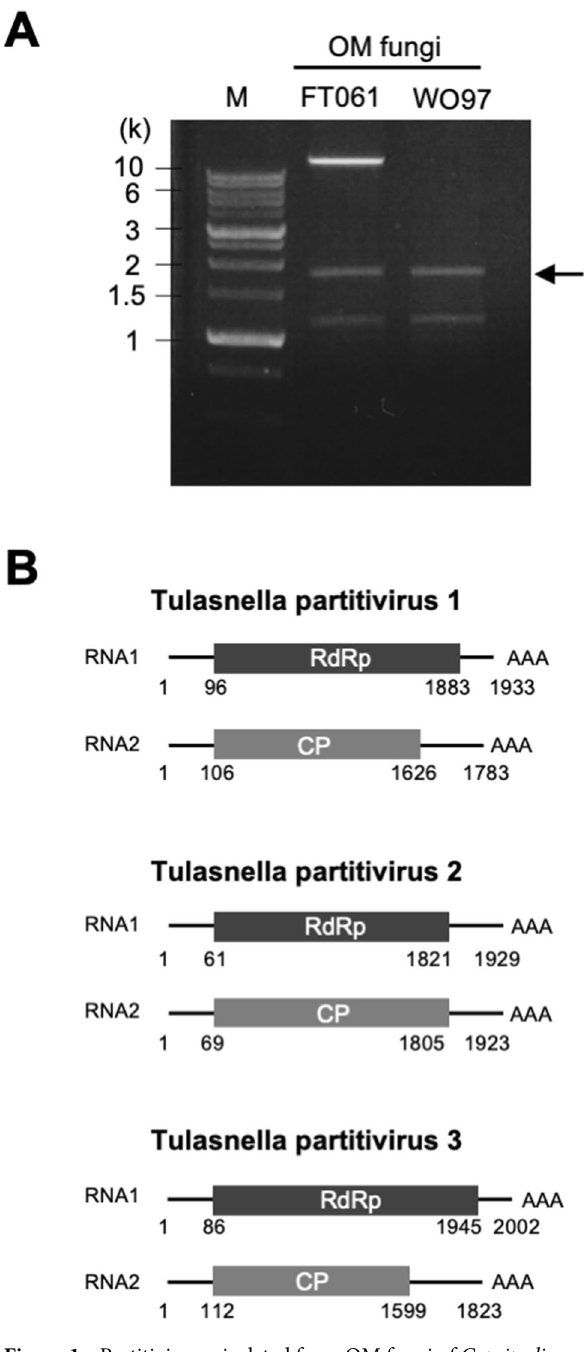
Figure 1. Partitiviruses isolated from OM fungi of Cypripedium macranthos var. rebunense . ( A ) dsRNAs extracted from two OM fungal strains (WO97 and FT061), which were detected in agarose gel electrophoresis. ( B ) Genome organization of Tulasnella partitivirus 1–3. The longer RNA (RNA 1) has a single open reading frame (ORF) encoding an RdRp and the shorter RNA (RNA 2) has a single ORF encoding a coat protein